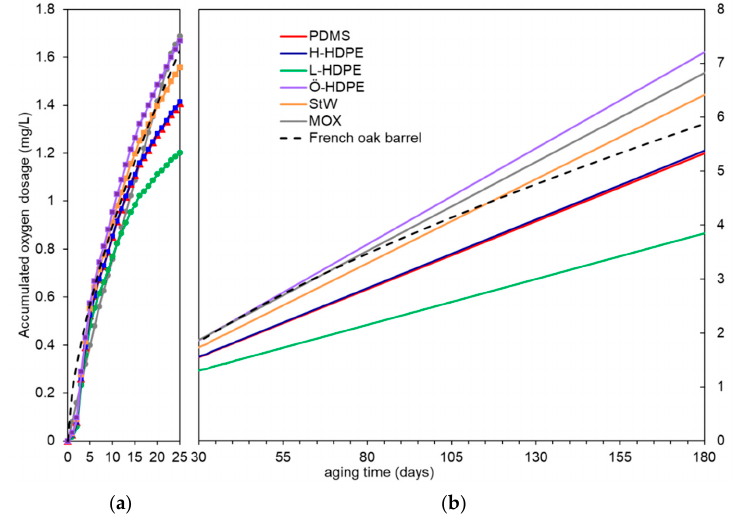
Figure 2. Graphic representation of the measurements of dissolved oxygen content accumulated (mg/L) in wines aged in different aging systems: ( a ) First days; ( b ) Whole experimental period.